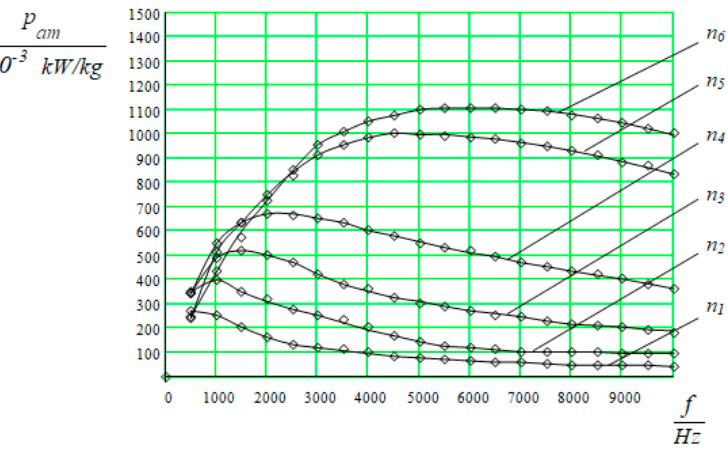
Figure 6. Dependences of the specific power p am on the current frequency at various generator rotation values: n 1 = 10 r/s; n 2 = 25 r/s; n 3 = 50 r/s; n 4 = 100 r/s; n 5 = 300 r/s; n 6 = 400 r/s.